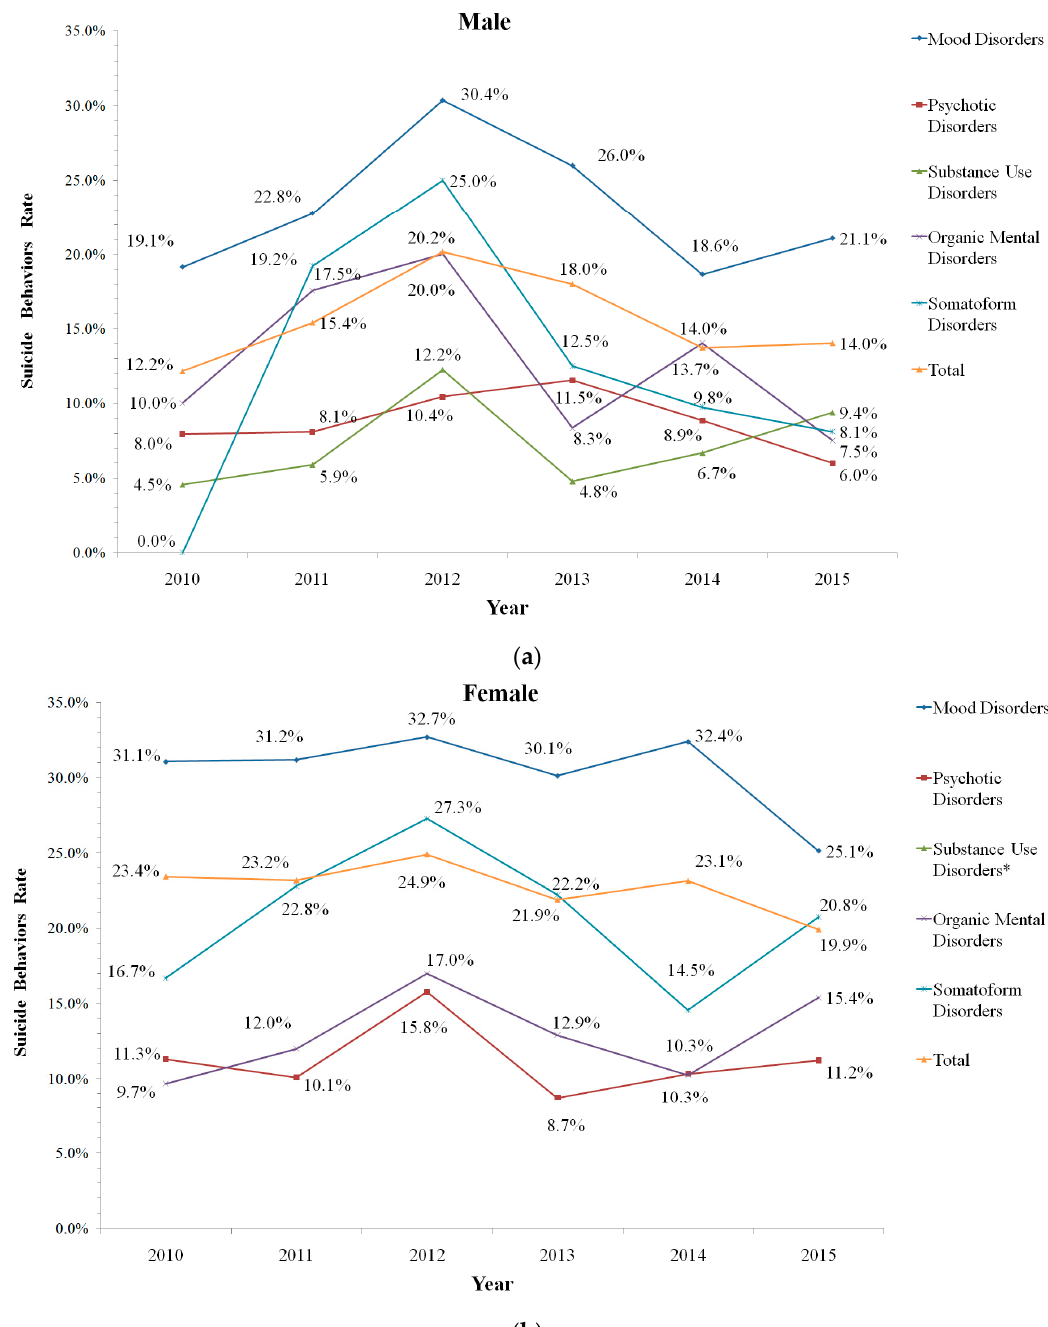
Figure 3. The suicidal behavior rates of ( a ) male and ( b ) female inpatients with mental disorders in Beijing Anding Hospital, 2010–2015. (* Substance Use Disorders was not shown because of the small numbers.). Table 3. The numbers and rates of suicidal ideation and attempted suicide for each category of mental disorders.